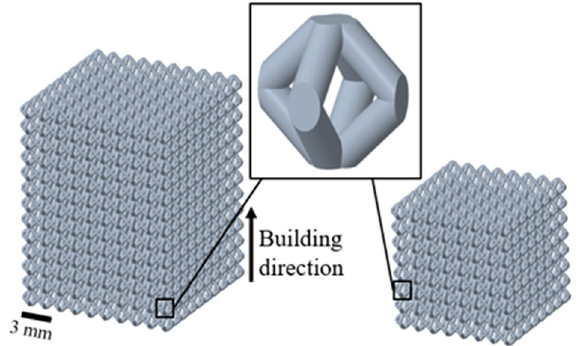
Figure 1. Specimen geometry for 20% relative density design for HIP (left) and as-built (right)